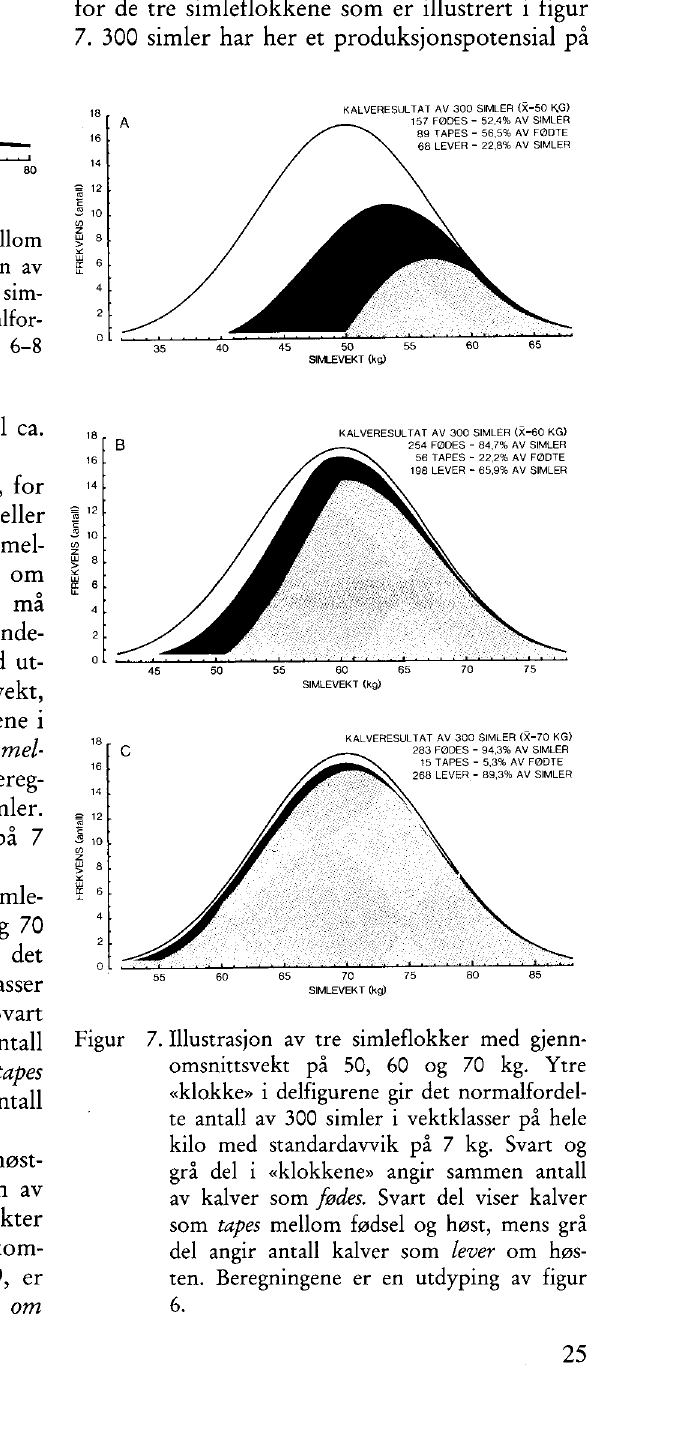
gur 10. Beregningsresultatene, med et standard avvik på 7 kg for simlevekten, er også gitt i ta bell 1.